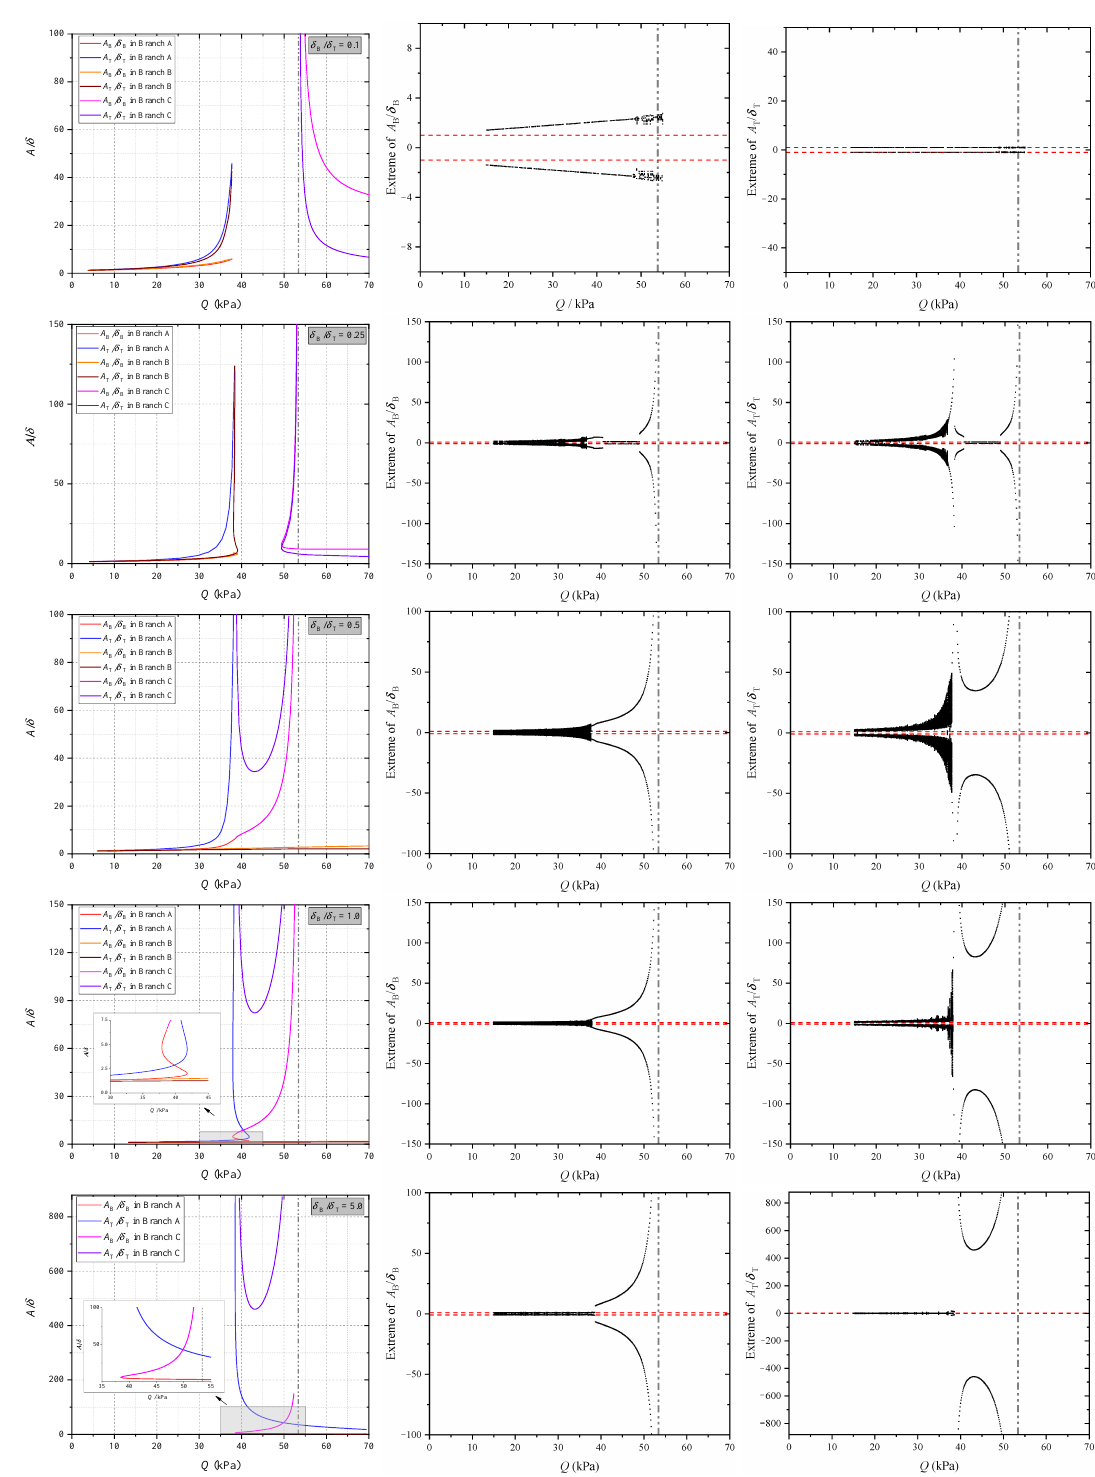
Figure 19. Frequency-domain LCO solutions and corresponding time-domain bifurcation diagrams in bending and torsional DOFs ( K B = 5.0 × 10 3 N · m/rad, K T = 1.5 × 10 3 N · m/rad, and δ B / δ T is 0.1, 0.25, 0.5, 1.0, and 5.0 from top to bottom). According to the solving interval and the continuity of the LCO solutions with the parameters, three LCO branches are defined here. In Figure 20, when δ B / δ T ≤ 0.25, LCO branches A and B are located on either side of the yellow dotted line (two solution intervals) and converge at the top right. In contrast, branch C is relatively independent. With